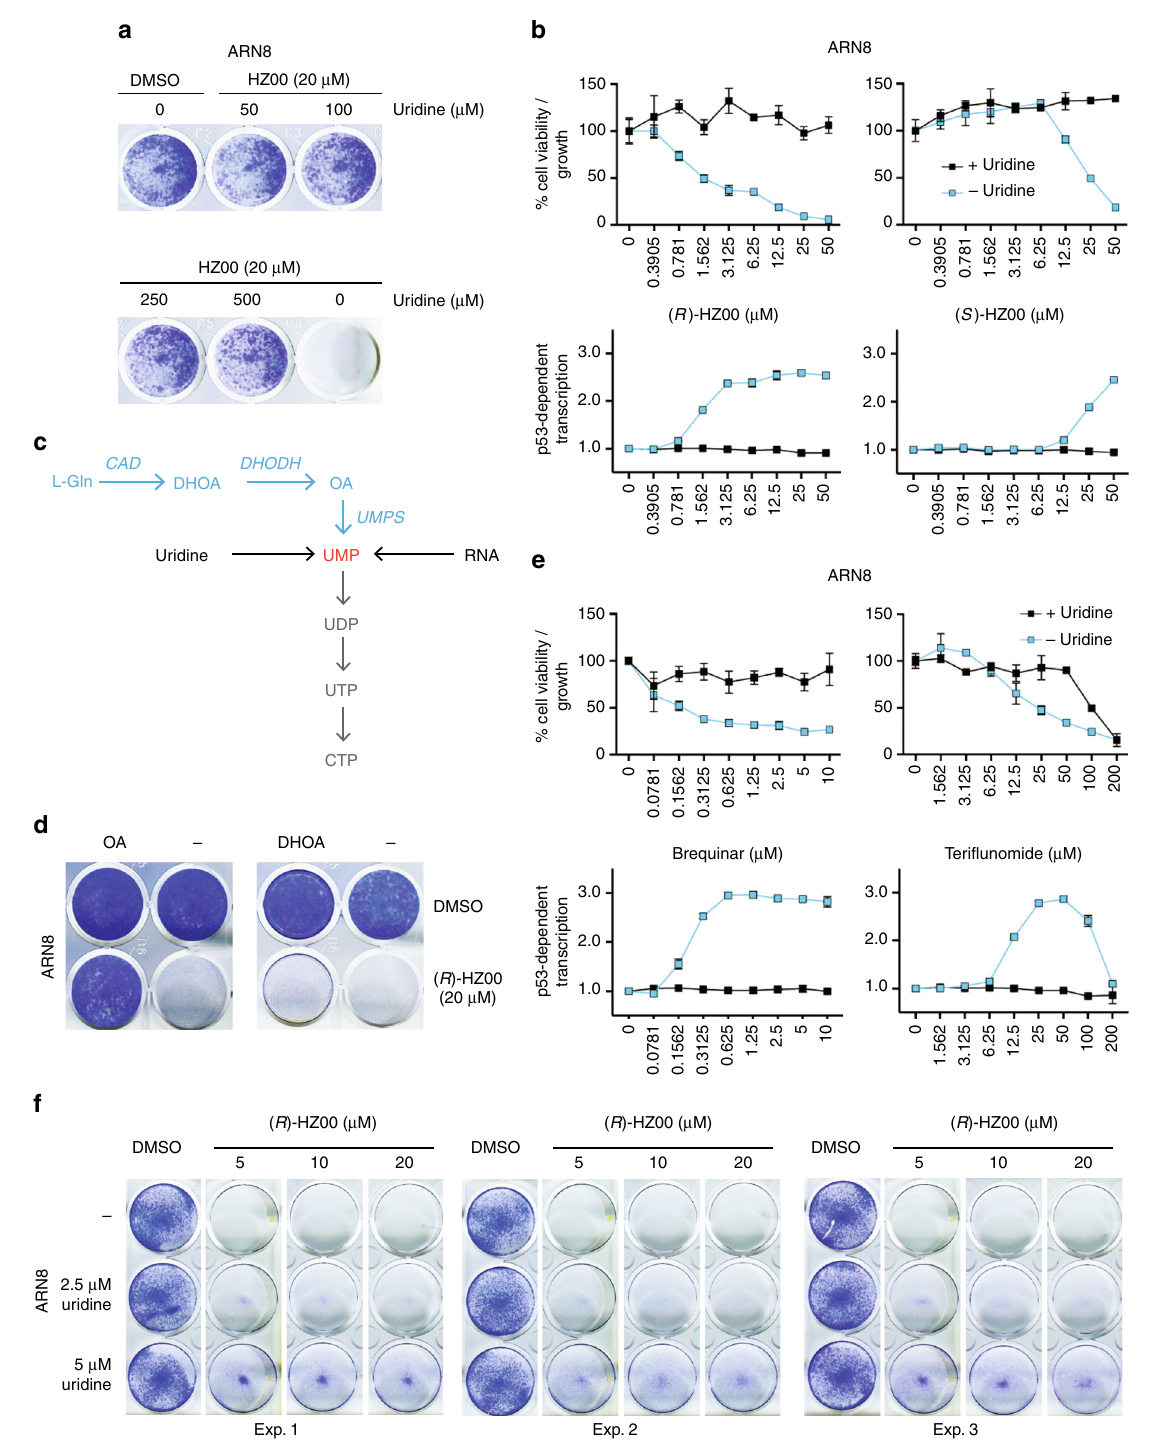
Fig. 4 DHODH is a target of HZ00. a ARN8 cells were treated with HZ00 and the indicated amounts of uridine for 96h followed by fi xation with 50:50 methanol:acetone and subsequent staining with 7.5% Giemsa solution. b ARN8 cells were treated for 96h with the indicated compounds in the presence and absence of uridine (100 μ M) and analyzed using an SRB assay. Additionally, ARN8 cells were treated for 16h and p53-dependent transcription was measured by CPRG assay. Values correspond to the average of three technical repeats±SD. c Simpli fi ed description of the pyrimidine nucleotide de novo (blue) and salvage (black) pathways. d ARN8 cells were seeded in FBS supplemented DMEM with a change to serum replacement medium 24h post seeding. Cells were treated for 6 days with ( R )-HZ00 in the presence of 1.5mM orotic acid (OA, Sigma #O2750) or 1.5mM dihydroorotic acid (DHOA, Sigma #D7003) and stained with Giemsa as described in a . e ARN8 cells were treated as in b but using DHODH inhibitors brequinar and teri fl unomide. Values correspond to the average of three technical repeats ±SD. f ARN8 cells were seeded in FBS supplemented DMEM with a change to serum replacement medium 24h post seeding. Cells were then treated with ( R )-HZ00 for 72h in the presence of 2.5 or 5 μ M uridine and stained with Giemsa as described in